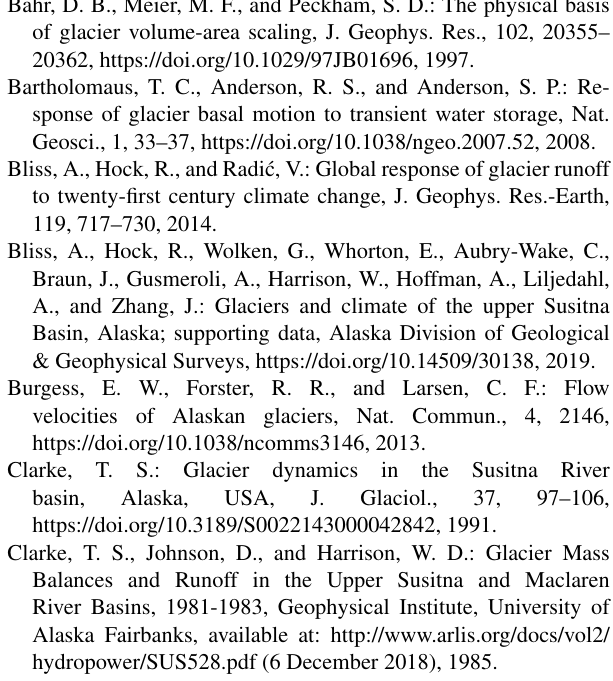
Fig. 1. Joanna Young and A. Cody Beedlow were instrumental in launching the